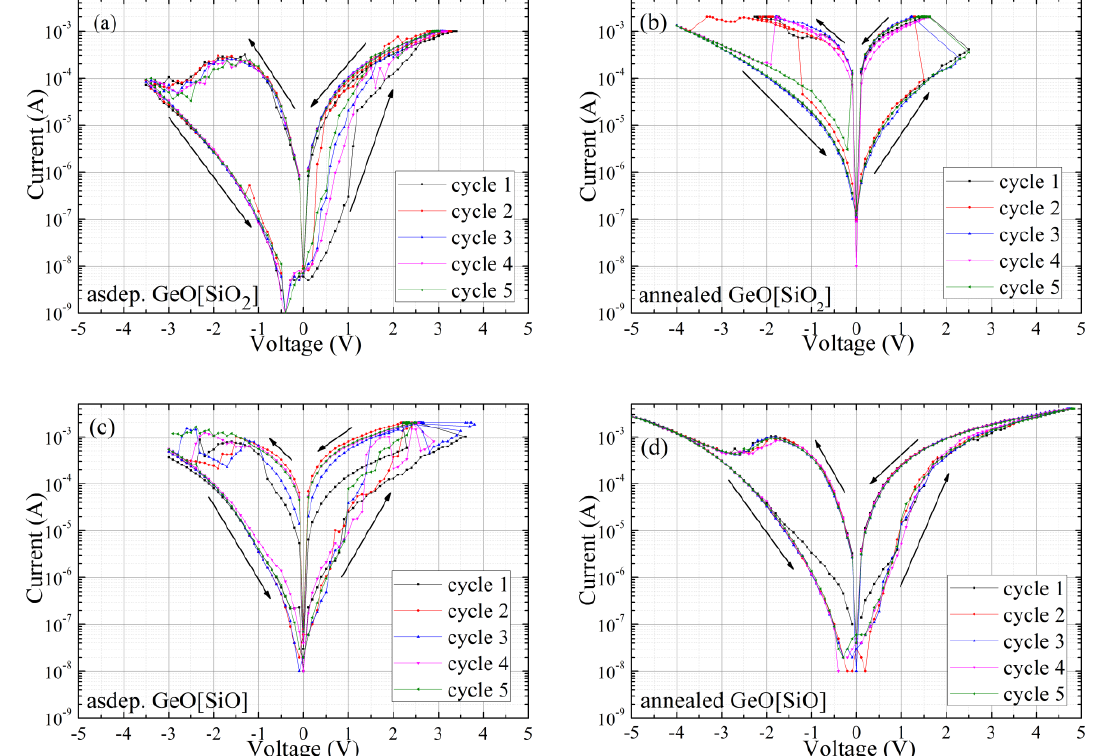
Figure6. Current–voltage(I–V)characteristicsoftheMISstructures. ( a )As-depositedITO / GeO[SiO 2 ] / p + Figure 6. Current–voltage (I–V) characteristics of the MIS structures. ( a ) As-deposited -Si (001) heterojunction; ( b ) Annealed ITO / GeO[SiO 2 ] / p + -Si (001) heterojunction; ( c ) As-deposited ITO/GeO[SiO 2 ]/p + -Si (001) heterojunction; ( b ) Annealed ITO/GeO[SiO 2 ]/p + -Si (001) heterojunction; ( c ) ITO / GeO[SiO] / p + -Si (001) heterojunction; and ( d ) annealed ITO / GeO[SiO] / p + -Si (001) As-deposited ITO/GeO[SiO]/p + -Si (001) heterojunction; and ( d ) annealed ITO/GeO[SiO]/p + -Si (001) heterojunction.